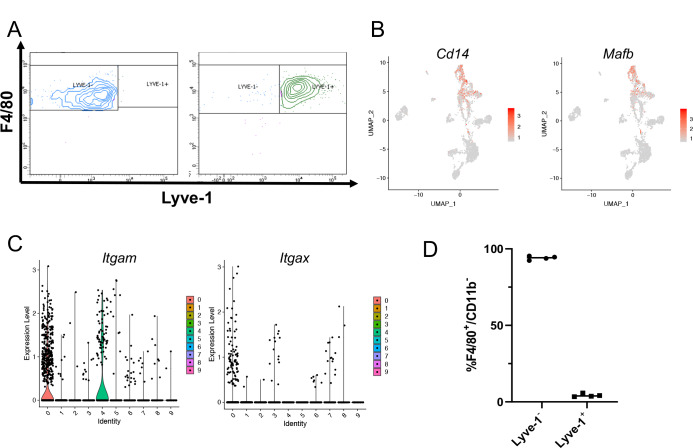
Identification of a distinct Lyve-1+ macrophage subpopulation by transcriptional profiling.(A) Post-sort analysis of CD45+CD11b+F4/80+Lyve-1– and CD45+CD11b+F4/80+Lyve-1+ cells that were submitted for bulk RNA-seq analysis. (B) scRNA-seq data showing genes associated with macrophages expressed in clusters 0 and 4. (C) Violin plots showing expression levels of Itgam and Itgax across clusters. (D) Graph showing Lyve-1 expression in F4/80+/CD11b– macrophages by flow cytometry.